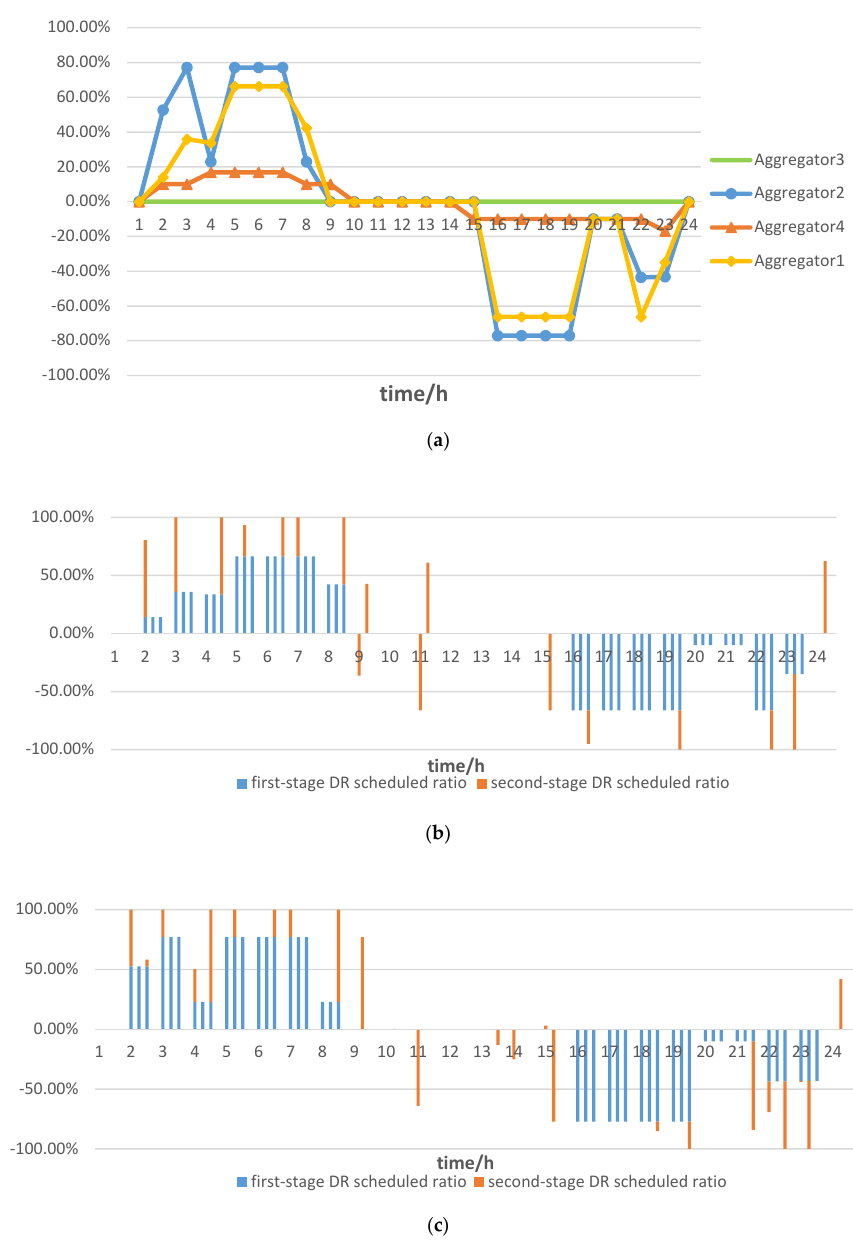
Figure 6. ( a ) The dispatch schemes of aggregator 1–4 in first ‐ stage for 24 h. Resources of aggregators 1 and 2 are most flexible. With the cost of dispatching DR resources of aggregators 1 and 2 decreasing, the dispatch volumes of them have increased dramatically; ( b ) Proportion of DR scheduled in two stages, results of aggregator 1; ( c ) Proportion of DR scheduled in two stages, results of aggregator 2.